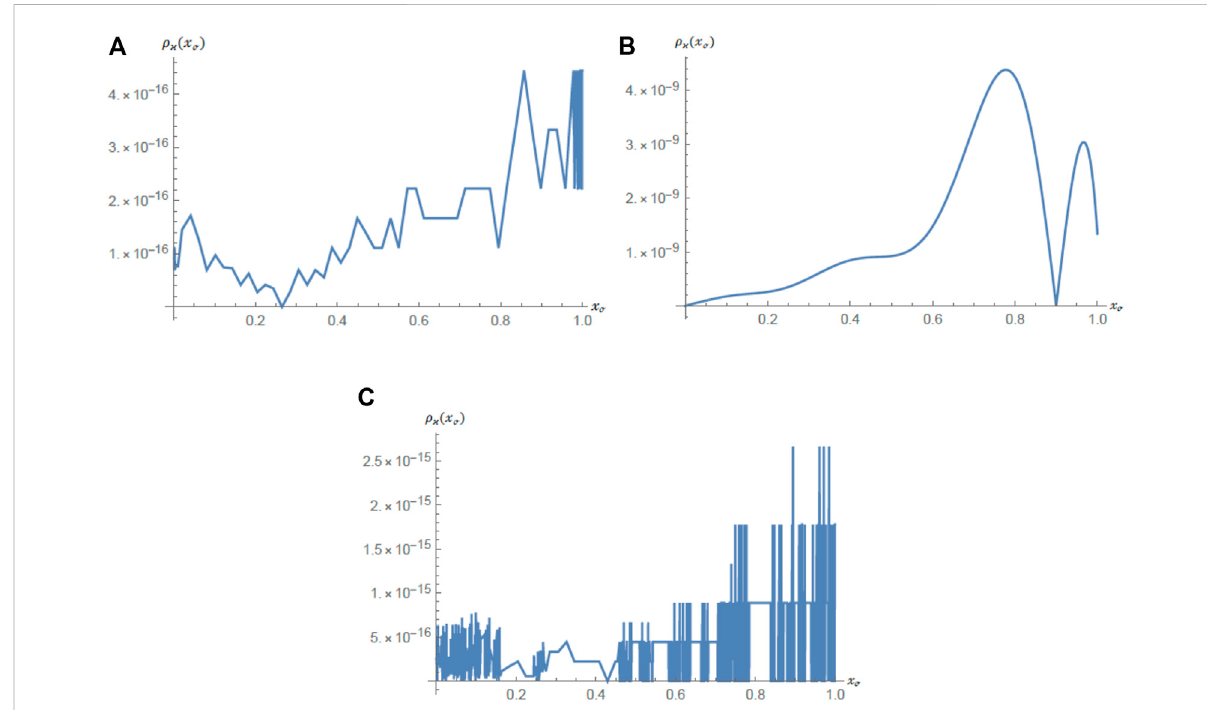
FIGURE 2 2- D Cartesian plots of RKHA absolute errors of the FLM platform over Ξ : (A) application 1, when ( α , β ) (cid:2) ( 1/2 , 4/5 ) ; (B) application 2, when ( α , β ) (cid:2) ( 1/3 , 3/4 ) ; and (C) application 3, when ( α , β ) (cid:2) ( 1/4 , 4/5 ) .